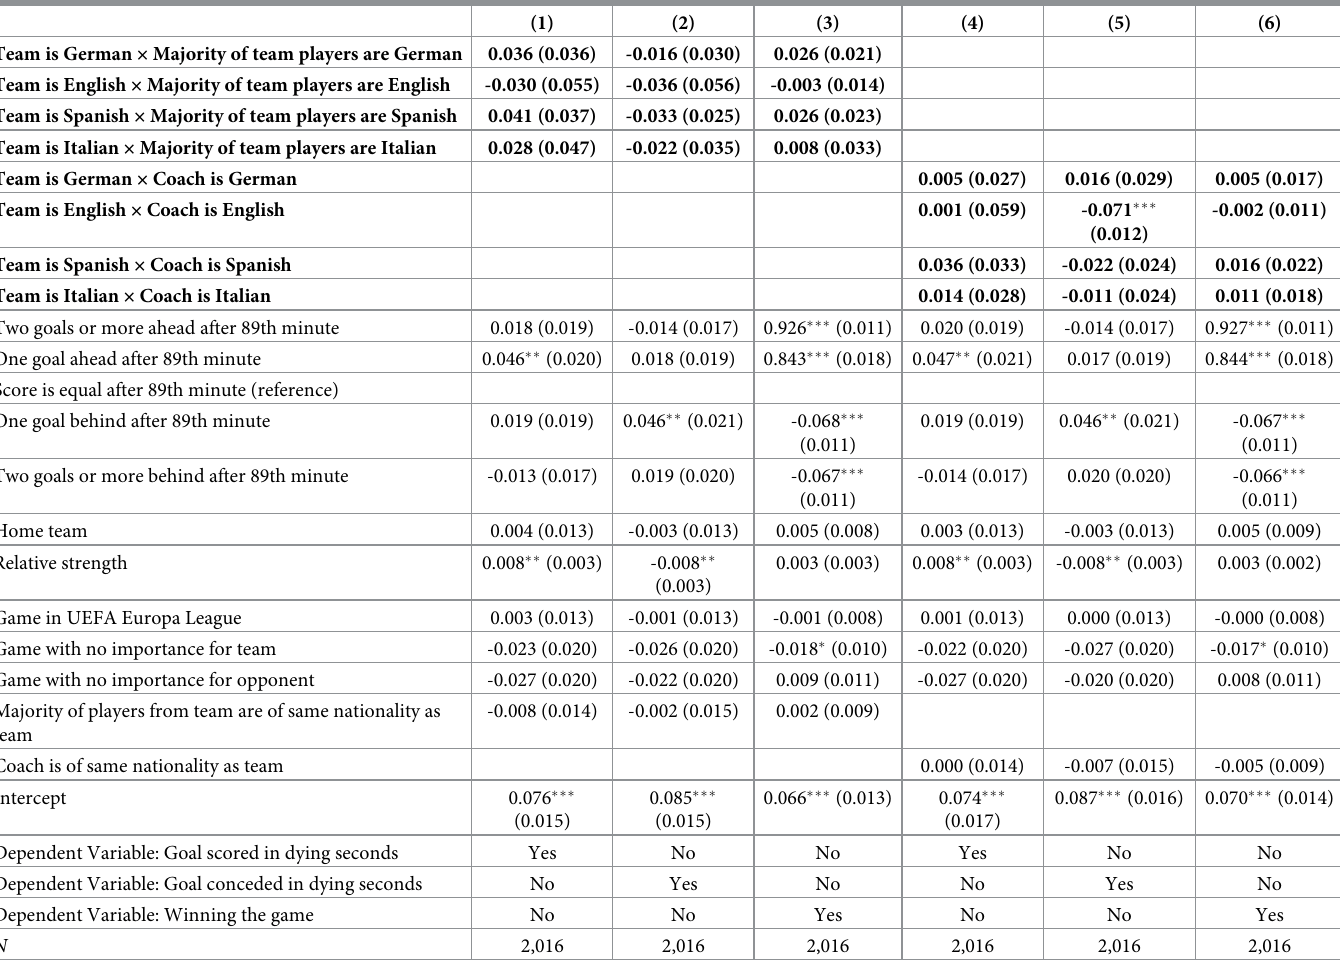
Table 5. Results: Interactions with nationality of players and coach as main explanatory